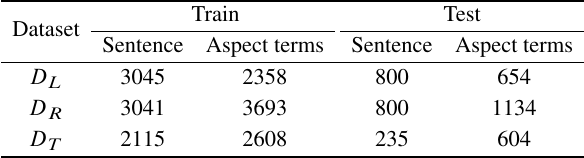
by three benchmark